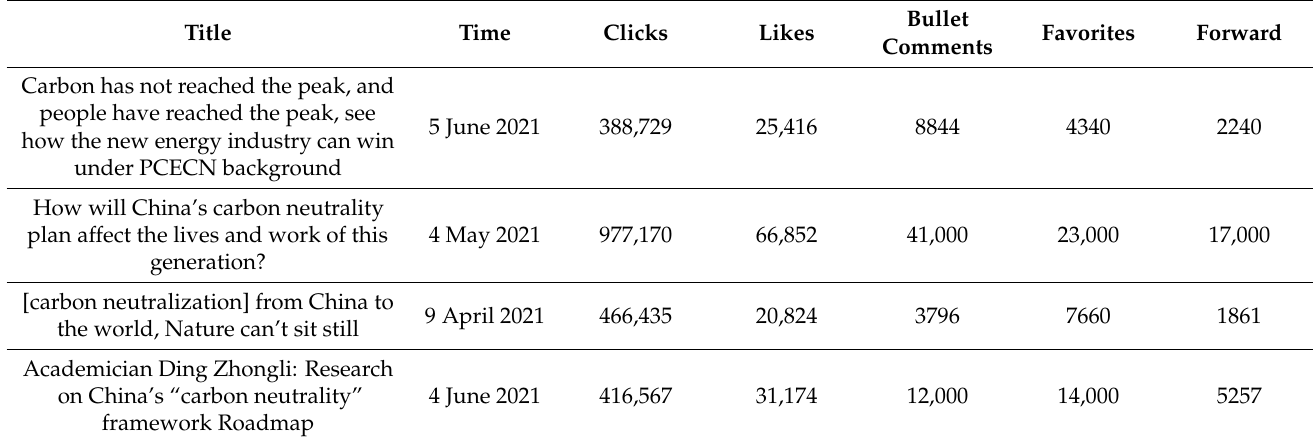
Table 2. Research object video title and related data.